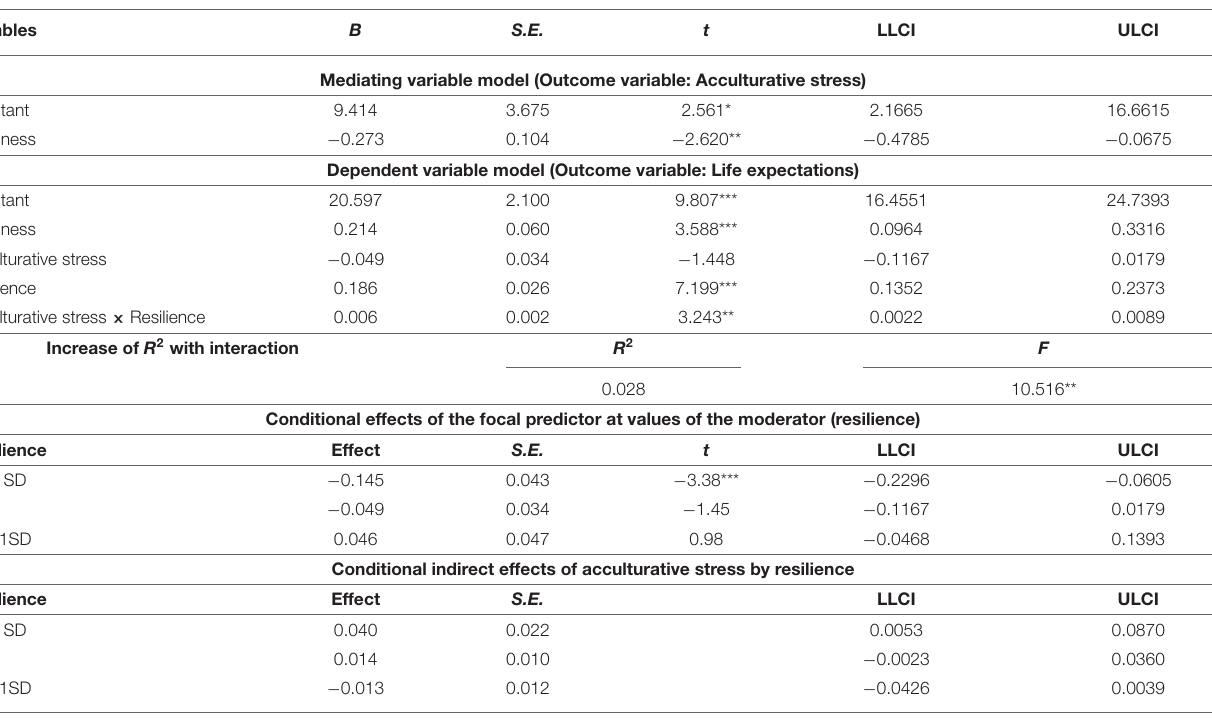
TABLE 4 | Moderating effect and moderated the mediating effect of resilience through acculturative stress on hardiness and life